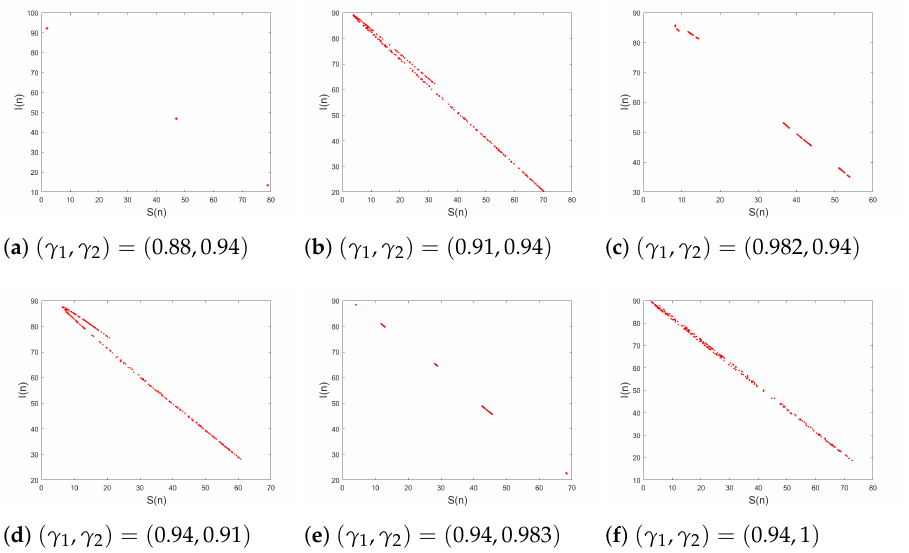
Figure 12. Phase portrait of the fractional discrete SIR epidemic model with vaccination (11) with incommensurate fractional-order values for N = 100, β = 0.8, σ = 0.1, p = 0.005, and initial conditions ( S ( 0 ) , I ( 0 )) = ( 70,30 ) .